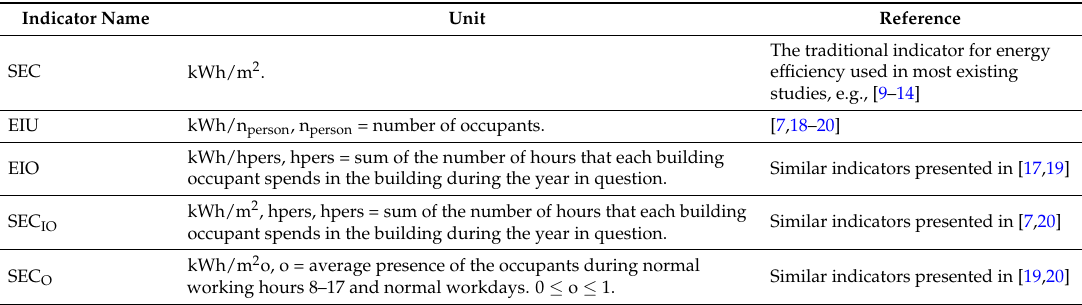
Table 1. Indicators used in this study. SEC: specific energy consumption; EIU: energy intensity